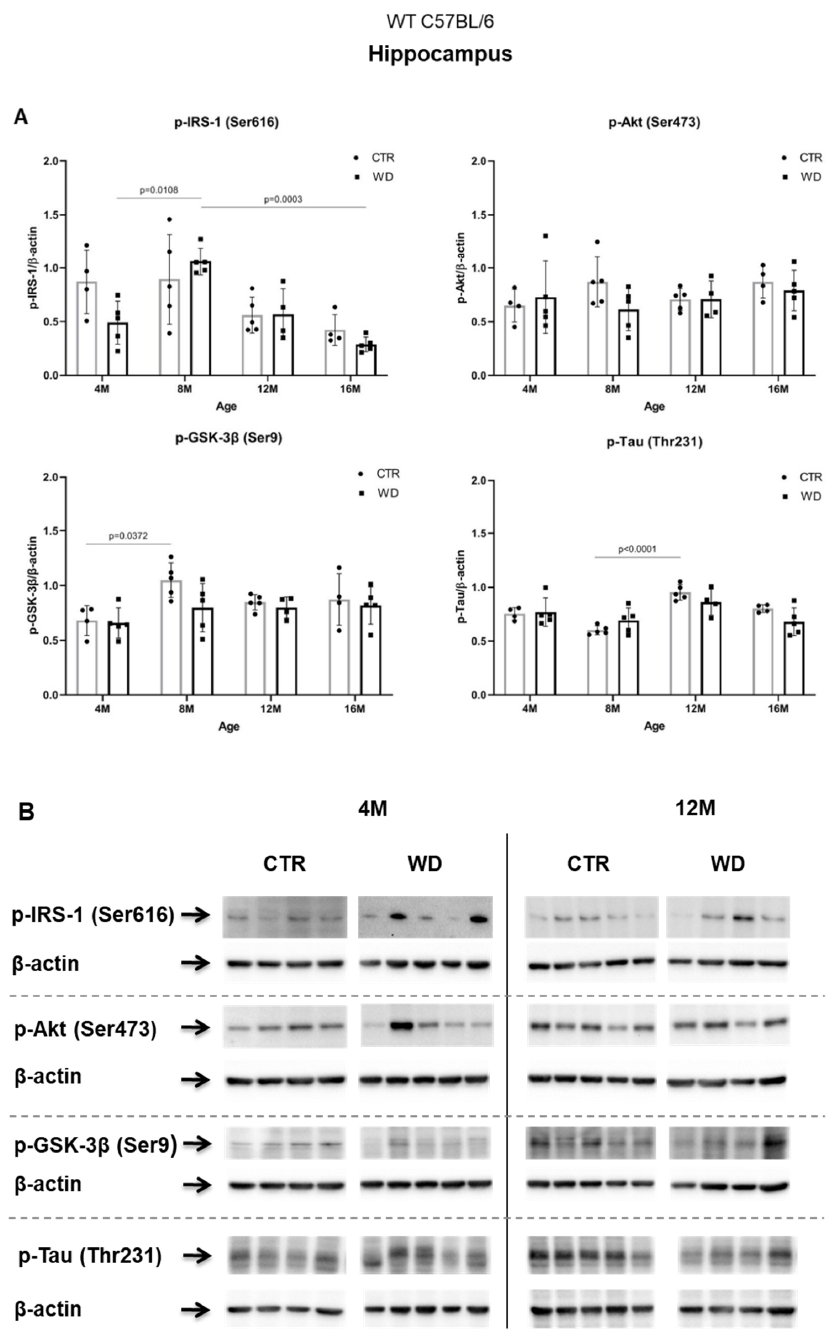
Figure 3. The levels of brain insulin signaling markers and tau phosphorylated at threonine 231 residue in the hippocampus of WT C57BL/6J mice. ( A ) Quantification and statistical analysis. ( B ) Representative source Western blots. Statistical analysis comprised the Shapiro–Wilk normality test, two-way ANOVA, and Tukey’s post hoc test; significant results: p-IRS-1 (Ser616): (4M WD vs. 8M WD ( p -Value = 0.0108); 8M WD vs. 16M WD ( p -Value: 0.0003); p-GSK-3 β (Ser9): (4M CTR vs. 8M CTR ( p -Value = 0.0372)); p-Tau (Thr231): (8M CTR vs. 12M CTR ( p -Value < 0.0001)). The source figures from Western blot analysis are attached in Appendix A: Figure A2a,b; Completed statistical data in Supplementary Materials Table